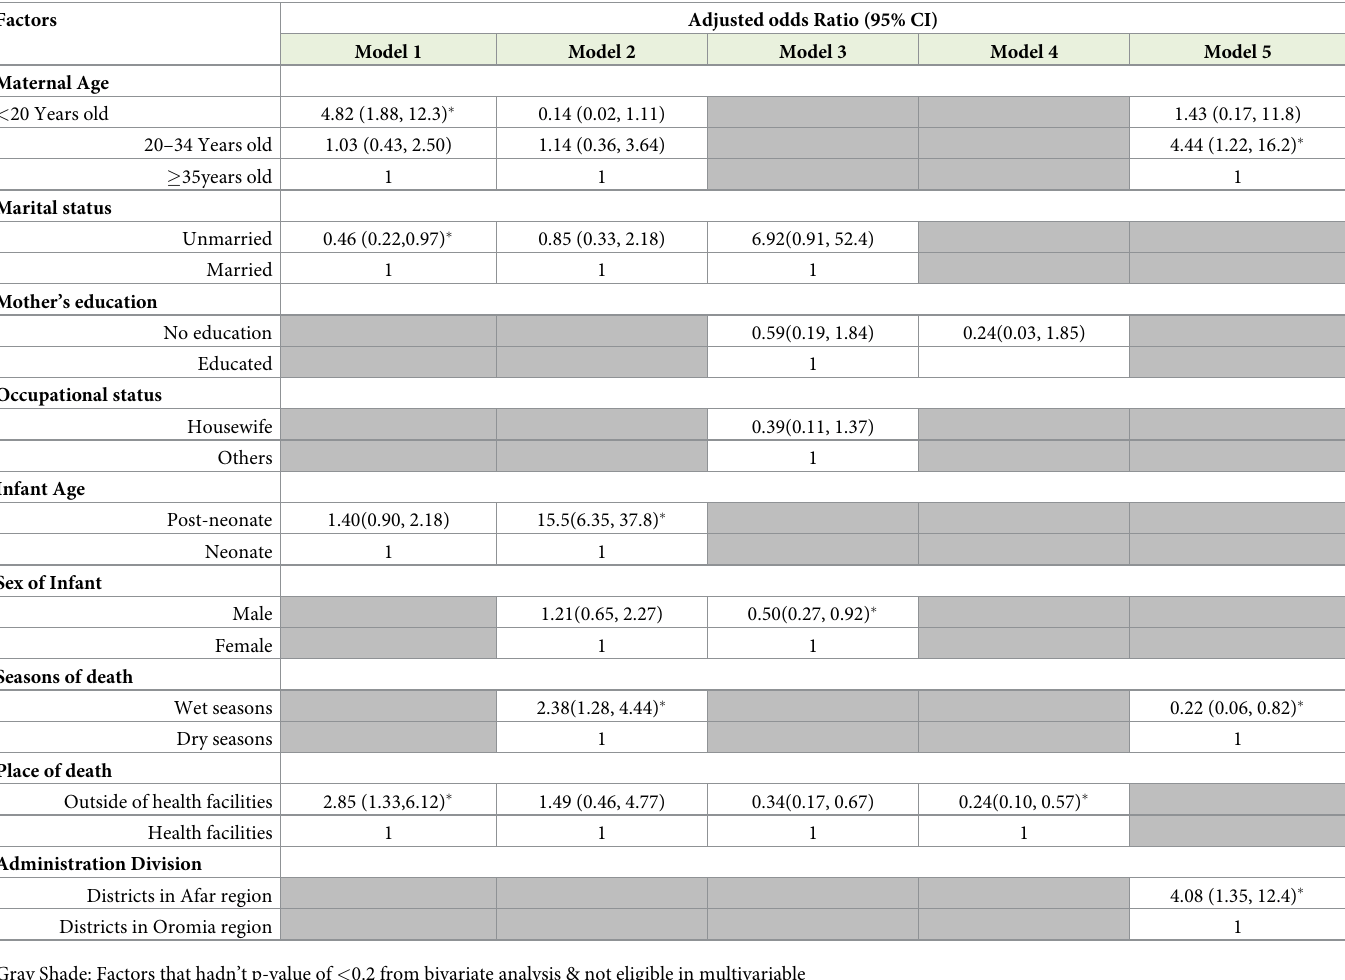
Gray Shade: Factors that hadn’t p-value of < 0.2 from bivariate analysis & not eligible in multivariable Model 1: Association of factors with deaths due to ARTI versus all other causes of death Model 2: Association of factors with deaths due to diarrhea versus other cause of death Model 3: Association of factors with deaths due to birth asphyxia versus other cause Model 4: Association of factors with deaths due to prematurity versus other cause of death Model 5: Association of factors with deaths due to malaria versus other cause of death � statistically significant at p <